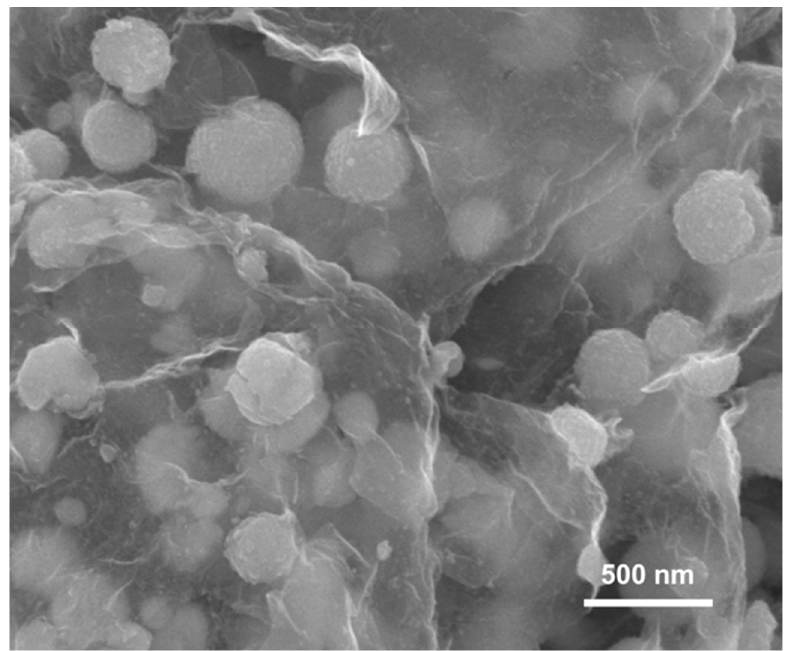
Figure A3. FESEM images of recycled Co 0.6 Ni 0.4 S 2 /rGO catalysts in synthesis of imine.